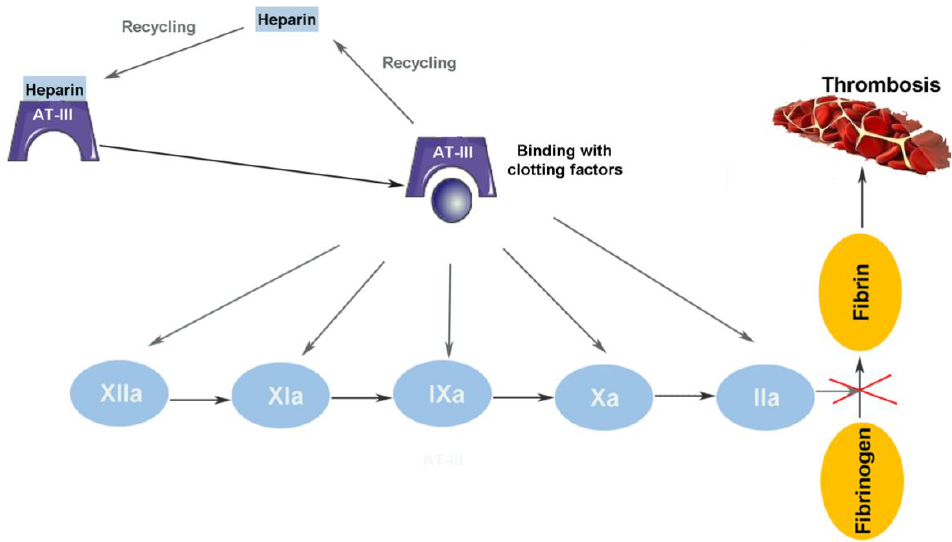
Figure 2. The interactions of heparin with the anticoagulant systems.